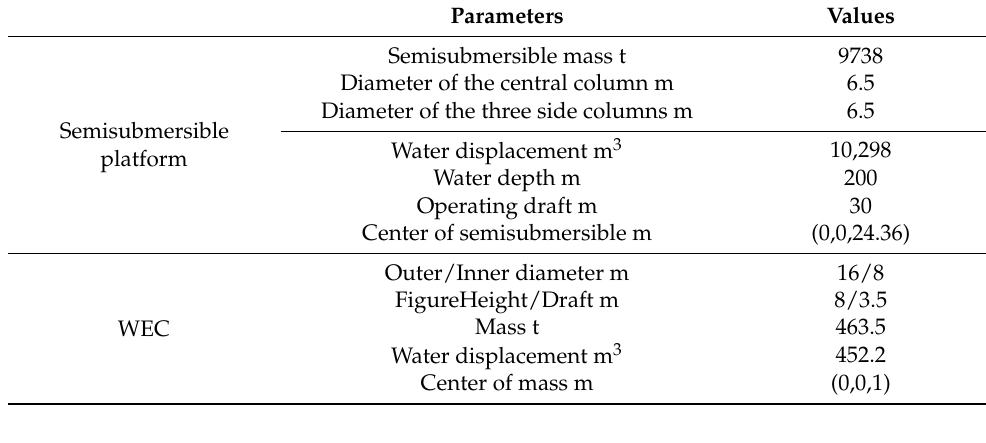
Figure 1. Sketch map of the combined system.